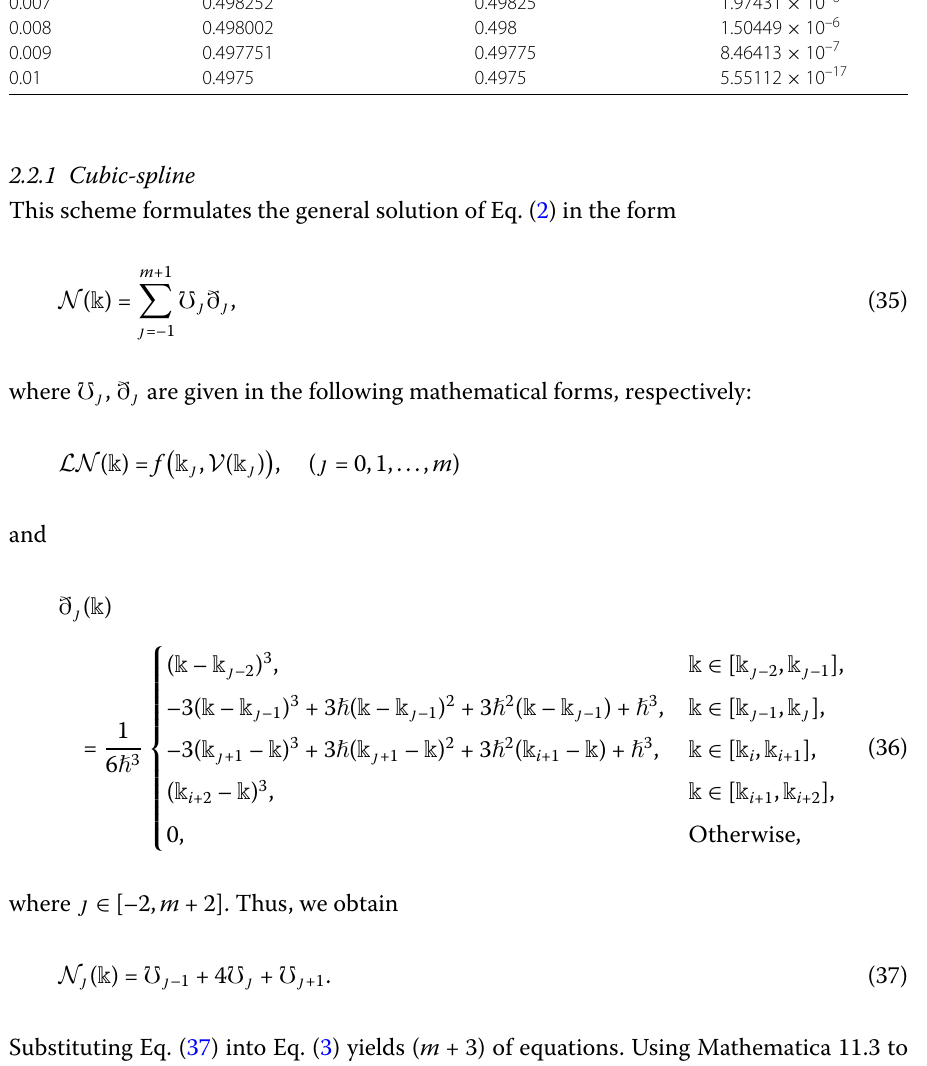
Table 1 Analytical, numerical, and absolute values in different values of k via cubic B-spline scheme, showing the accuracy of the obtained analytical solution Value of k Approximate values Analytical values Absolute values of error 0 0.5 0.5 5.55112 × 10 –17 0.001 0.499751 0.49975 8.45294 × 10 –7 0.002 0.499502 0.4995 1.50299 × 10 –6 0.003 0.499252 0.49925 1.97301 × 10 –6 0.004 0.499002 0.499 2.25524 × 10 –6 0.005 0.498752 0.009 0.497751 0.49775 8.46413 × 10 –7 0.01